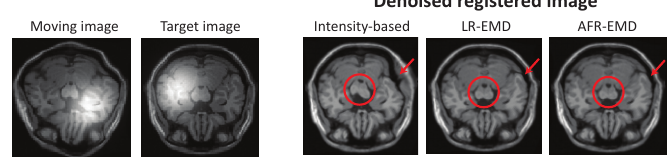
Figure 6. Target and reference images from BrainWeb MR dataset and registered images using our two methods and intensity-based hierarchical algorithm. MI is used as the similarity measure. Visually, both LR-EMD and AFR-EMD improve the registration accuracy in the center of image (red circle) and at the edge (red